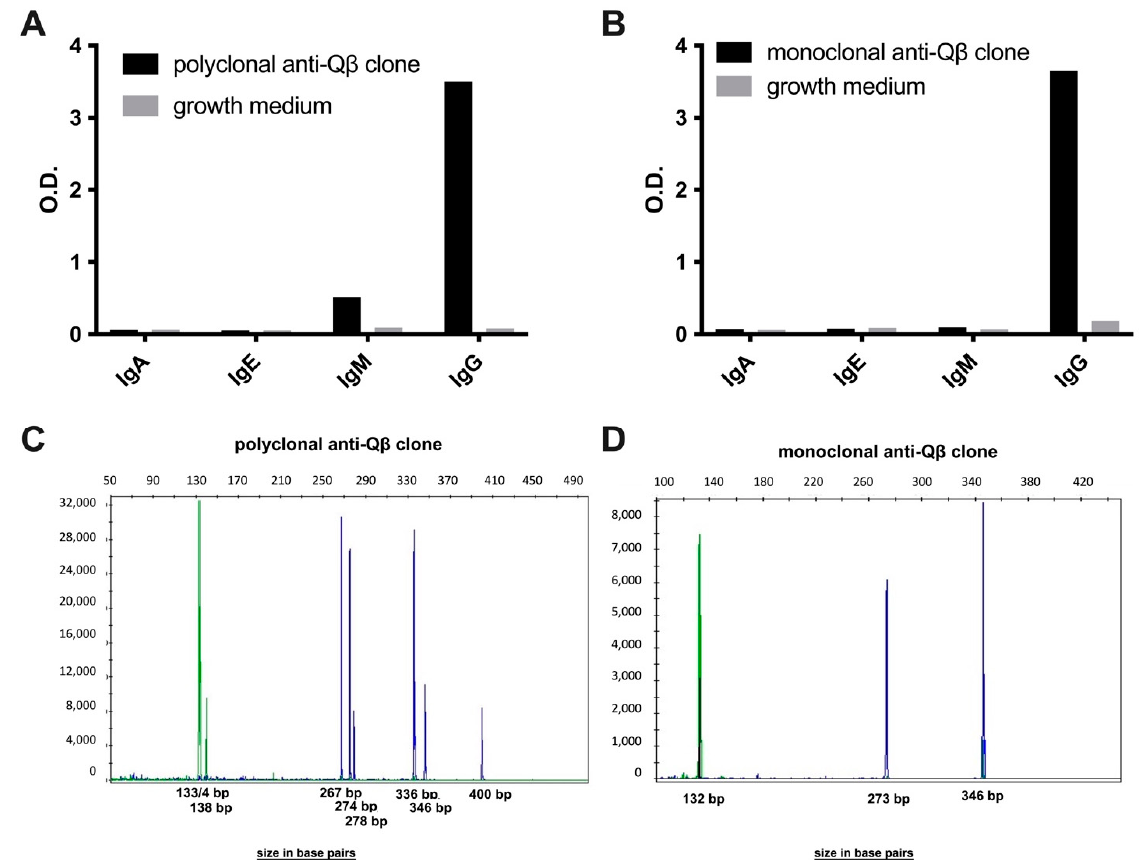
Figure 2. EBV transformed lymphoblasts from a patient treated with vidutolimod produce polyclonal and monoclonal antibodies specific for anti-Q β . B cells from a patient treated with vidutolimod were transformed with EBV and selected for anti-Q β specificity. Antibody isotyping and PCR-clonality was assessed. ( A , B ) Supernatant from polyclonal and monoclonal human anti-Q β -producing lymphoblasts was added to plates coated with vidutolimod and probed with antibodies specific for IgA, IgE, IgM, and IgG. ( C , D ) An InVivoScribe IGH PCR gene clonality test on DNA purified from polyclonal and monoclonal anti-Q β -producing lymphoblast clones confirmed polyclonality and monoclonality,